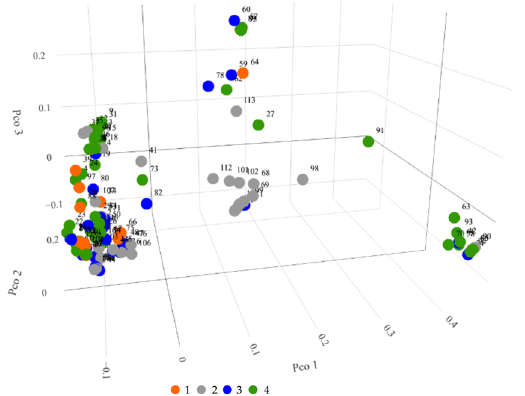
Figure 7. Results of Principal Coordinate Analysis (PCoA) for 116 spring barley landraces with indication of disease resistance. The accession numbers according to Table S1. The RotaTable 3D figure can be found in the Supplementary Materials (Figure S6).